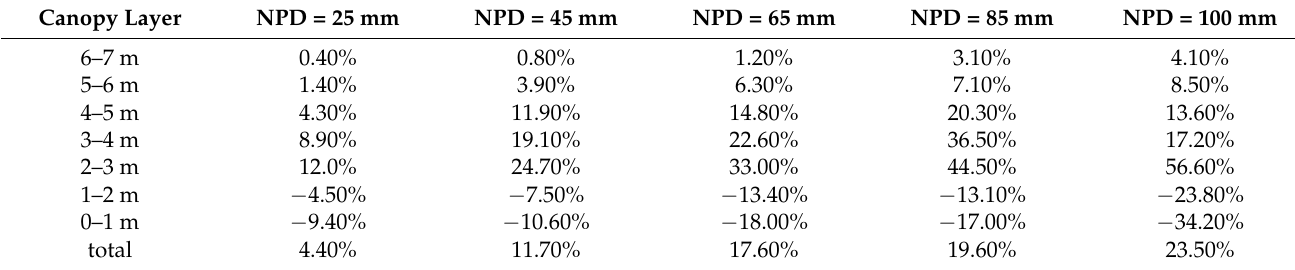
Table 2. The differences between sunlit leaf fractions calculated based on TLS data with other neighboring point distances (NPDs) and the reference one calculated based on TLS data with an NPD of 5 mm (differences = other NPDs—5